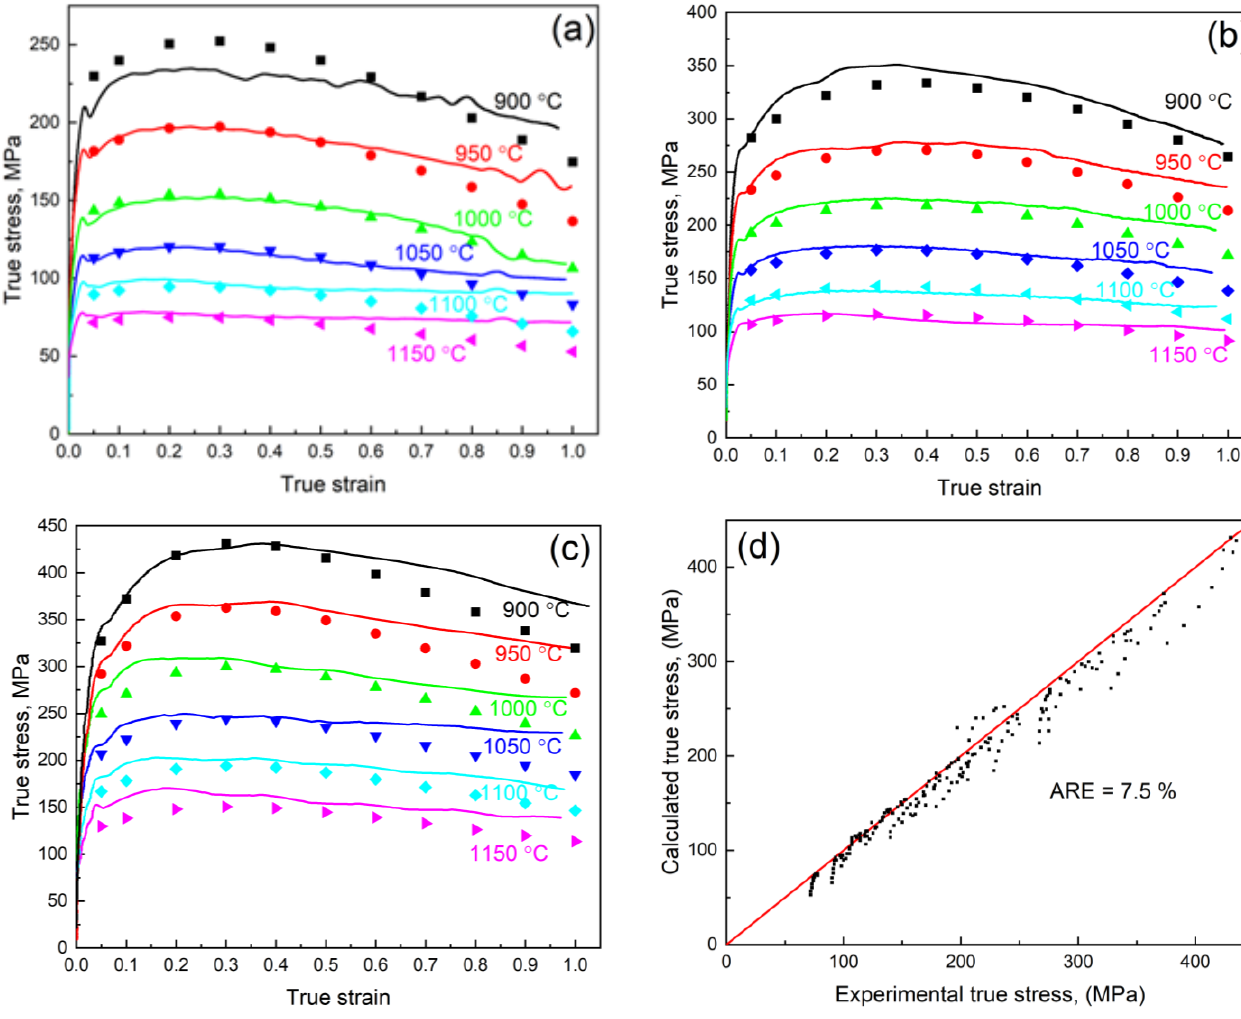
Figure 6. A matching of the experimental (lines) and calculated (dots) stress for the Fe–28Mn–8Al–1C steel deformation at a deformation rate of 0.1 s −1 ( a ), 1 s −1 ( b ), 10 s −1 ( c ), and for all thermomechanical modes ( d ).